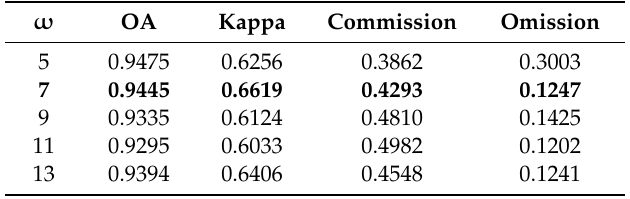
Table 5. Accuracy under di ff erent patch sizes on the first dataset.